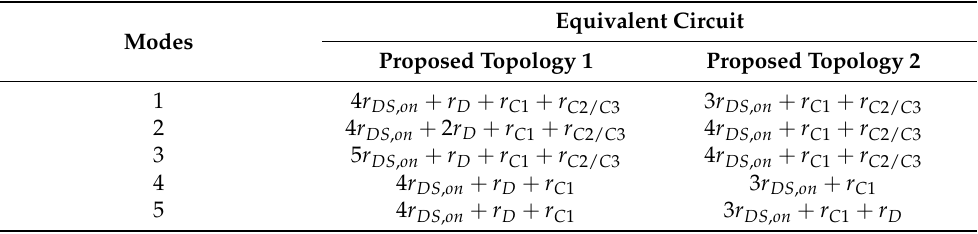
Table 3. Equivalent Circuit for Each